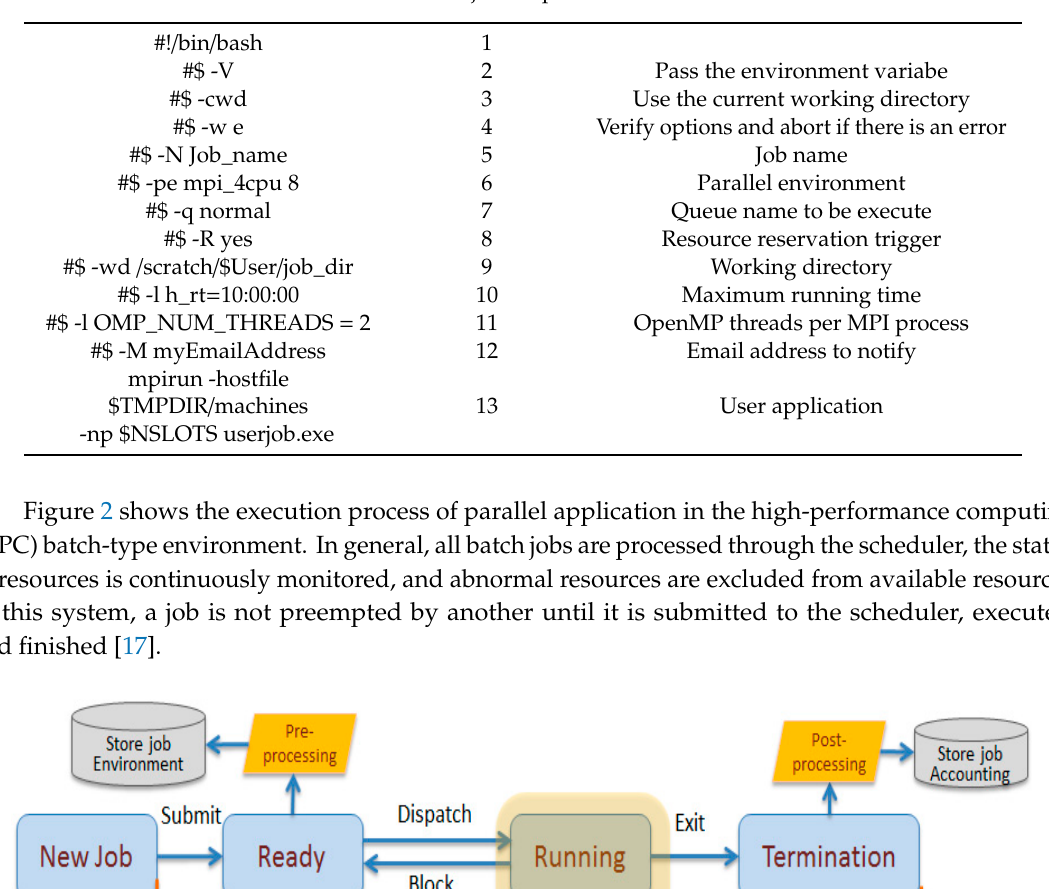
Table 1. Batch job script for submission.